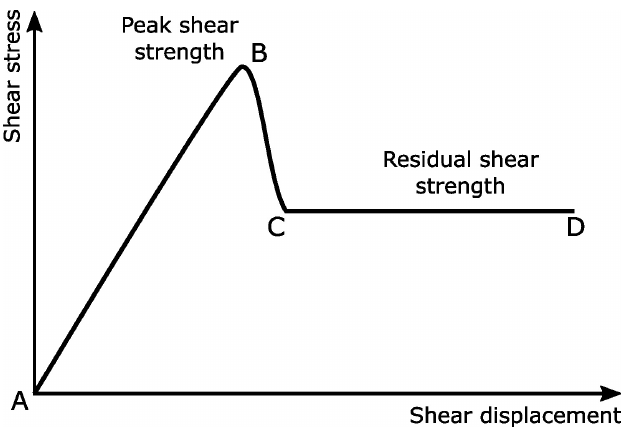
Figure 15. Idealization of the evolution of the shear stress of concrete–rock